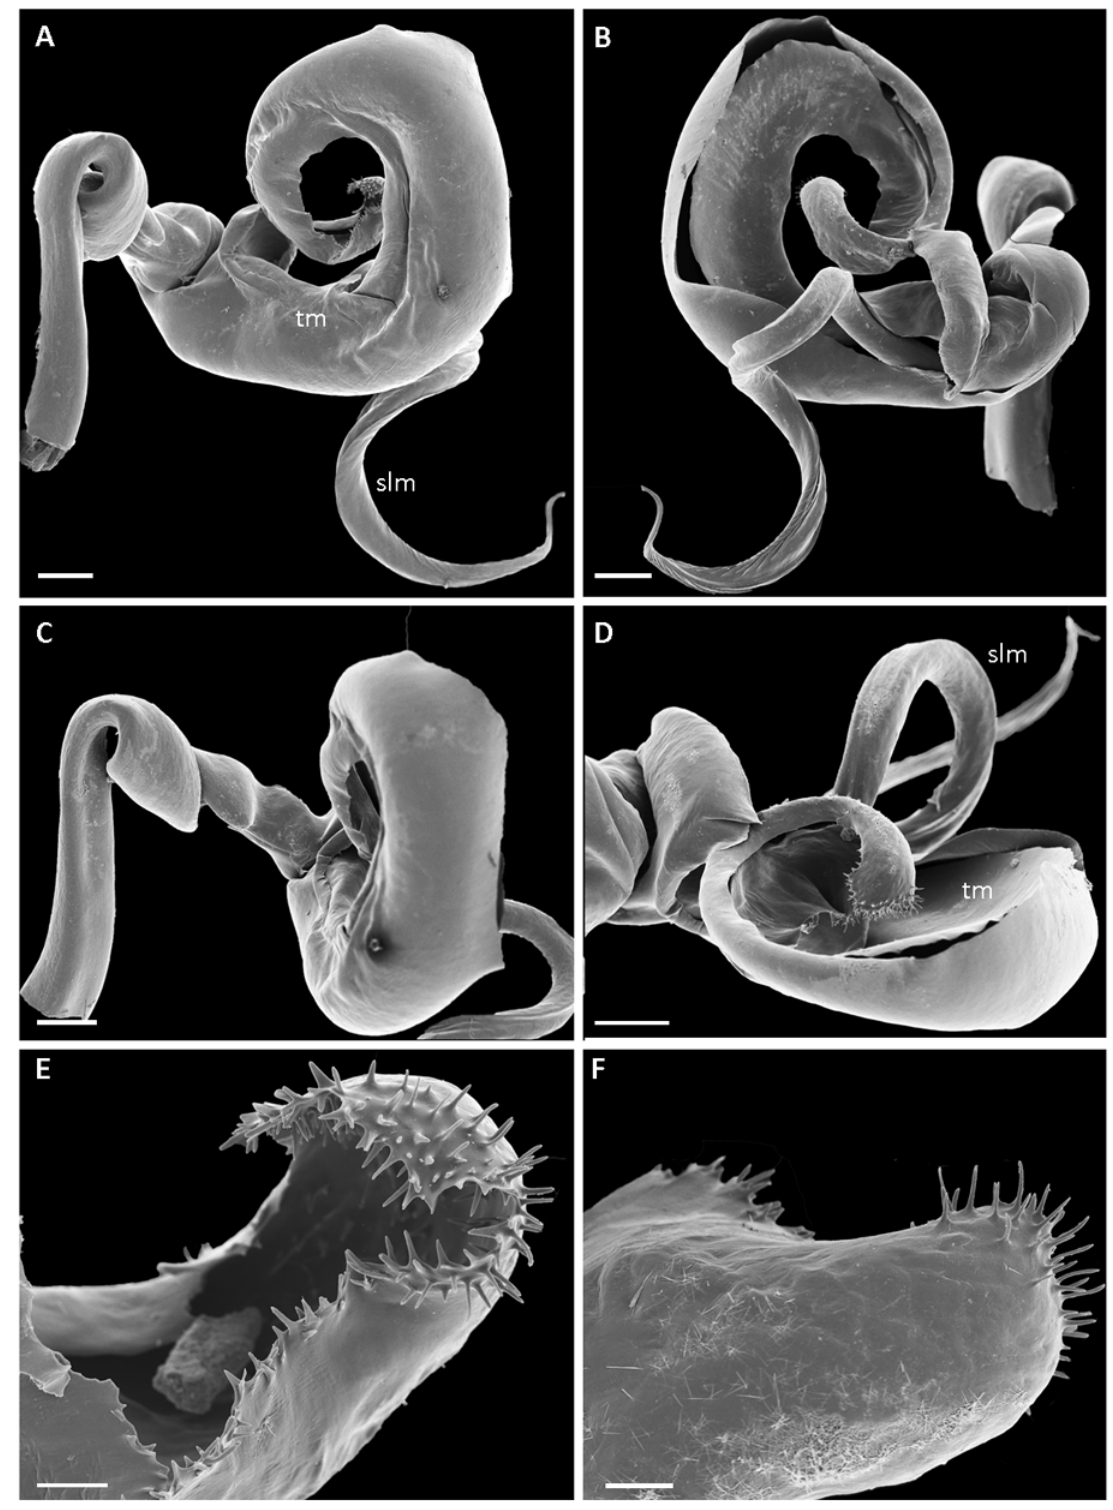
Fig. 13. Aquattuor mollilobus sp. nov., paratype, ♂ (NHMD 621648). Left gonopod telopodite. A . Anterior view. B . Posterior view. C . Submesal view. D . Distal (ventral) view. E – F . Tip of telomere. Abbreviations: slm = solenomere; tm = telomere. Scale bars: A–D = 0.1 mm; E–F = 0.02